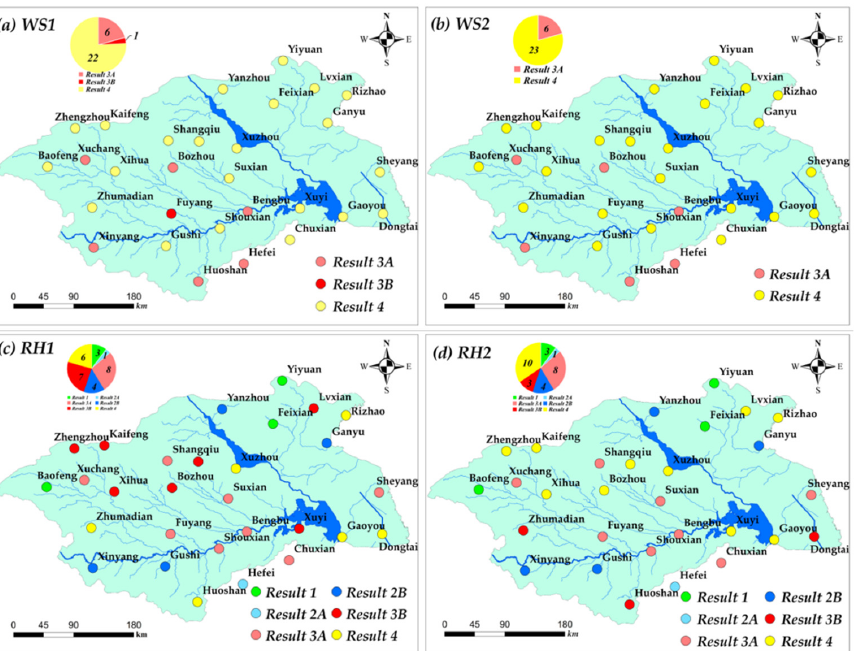
Figure 12. Trend test result for WS and RH series of the HRB. (Note: ( a , c ) are the results of the MMK test represented by the subscript Ⅰ ; and ( b , d ) are the results of the OW operation represented by the subscript Ⅱ ).